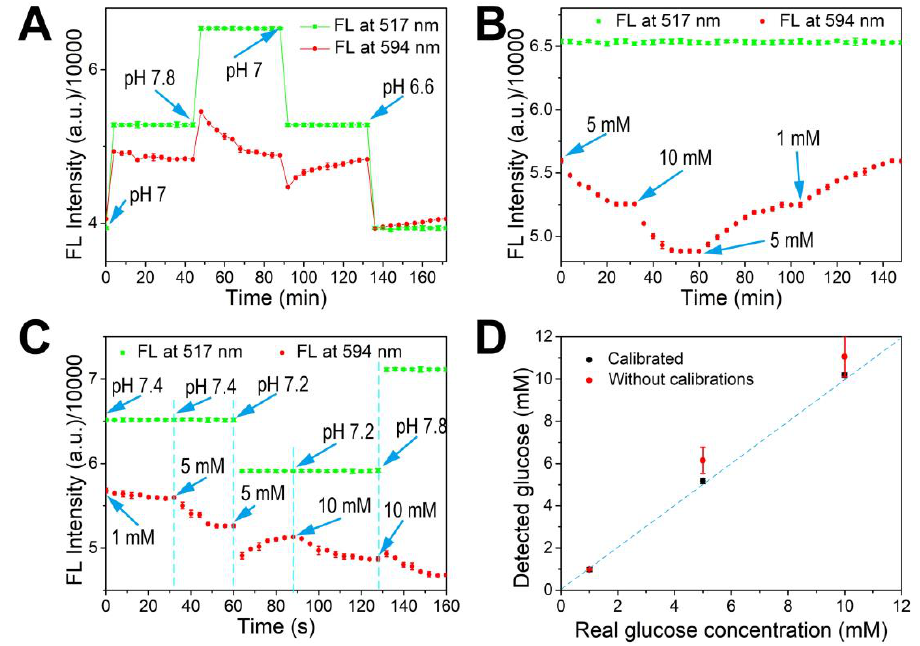
Figure 6. ( A ) Time response of fluorescence intensity at 517 nm and 594 nm when pH changed in the range of 6.6–7.8 with a fixed glucose concentration of 10 mM. The dots represent the fluorescence intensity recorded every 4 min, which is the same as ( B , C ). The moments when pH and glucose concentration start to change are pointed out with arrows, which are the same as ( B , C ). The solid line is for ease of understanding. ( B ) Time response of fluorescence intensity at 517 nm and 594 nm when glucose concentration changed in the range of 1 – 10 mM with fixed pH at 7.4. ( C ) Time response of fluorescence intensity at 517 nm and 594 for cross changes of pH and glucose concentration. The cyan vertical dashed lines play the same role as the arrows. ( D ) Deviation of glucose detection in ( C ). The blue dashed line indicates that the detected glucose concentration equals the actual glucose concentration. All error bars are based on standard deviations (n = 3).